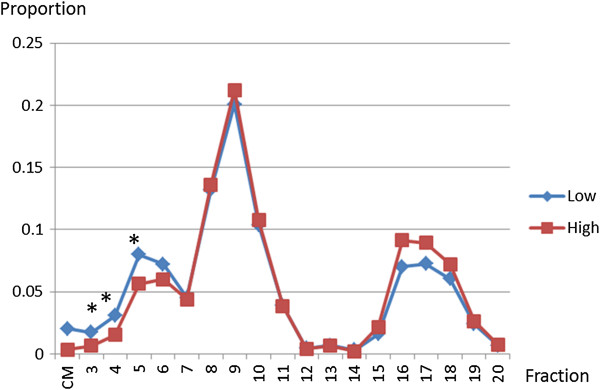
Cholesterol proportions in different lipoprotein fractions to total cholesterol level in low-ABI group compared with those in high-ABI group. Average proportion of cholesterol level in each lipoprotein fraction to total cholesterol level is indicated in the graph. The values are compared between the groups by the t-test and Mann–Whitney U test as appropriate. *, p<0.05. Abbreviations: proportion, average of the proportion of cholesterol level in each lipoprotein fraction to total cholesterol level; High-ABI group, group of patients with high ABI (ABI>0.9); Low-ABI group, group of patients with low ABI (0.9 or low); CM, chylomicron; F3-20, Fractions 3–20.